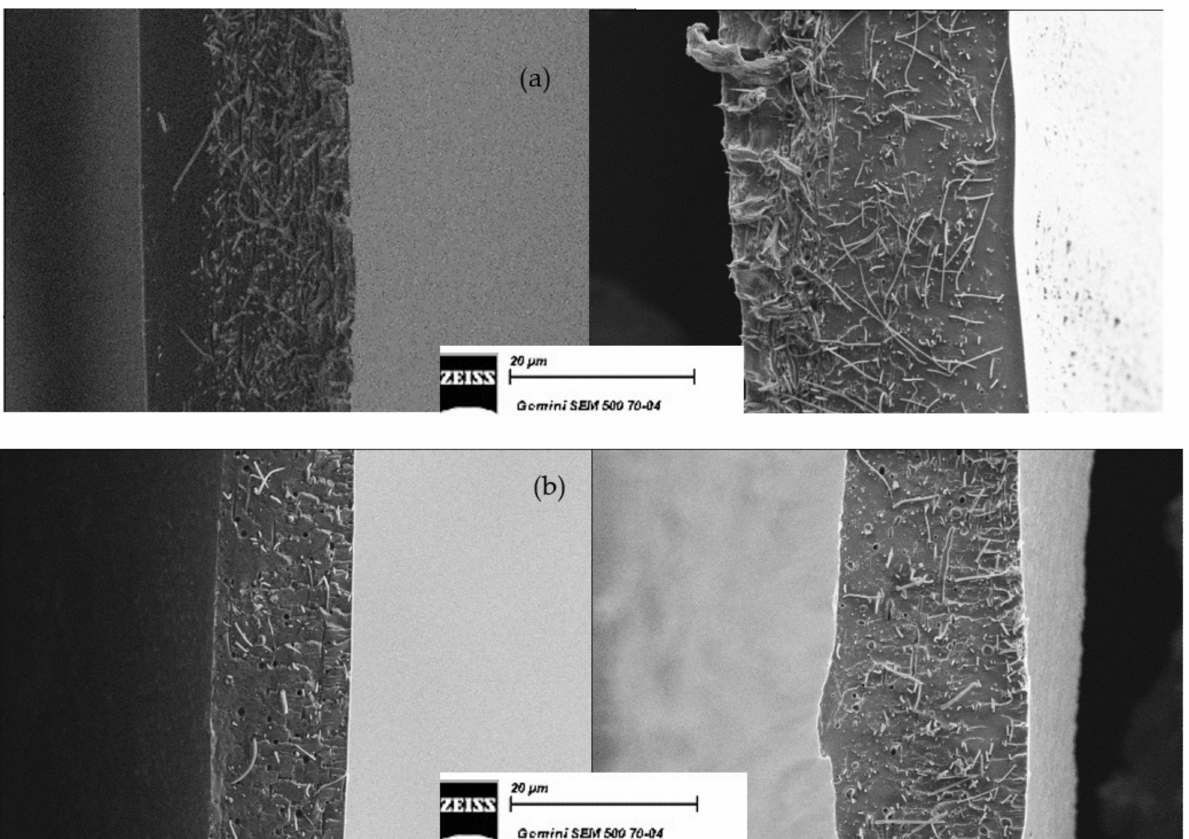
Figure 3. Cross-sectional SEM micrographs of reinforced membranes before ( left ) and after ( right ) the swelling in buffer. ( a ) K-EW_R and ( b ) U-E_R_TT. Magnification: 1000 ×